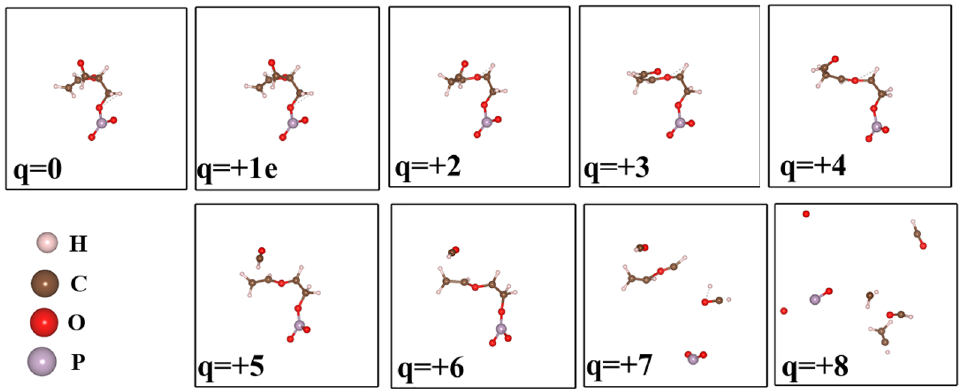
Figure 8. The effect of electron removal in a fragment of DNA